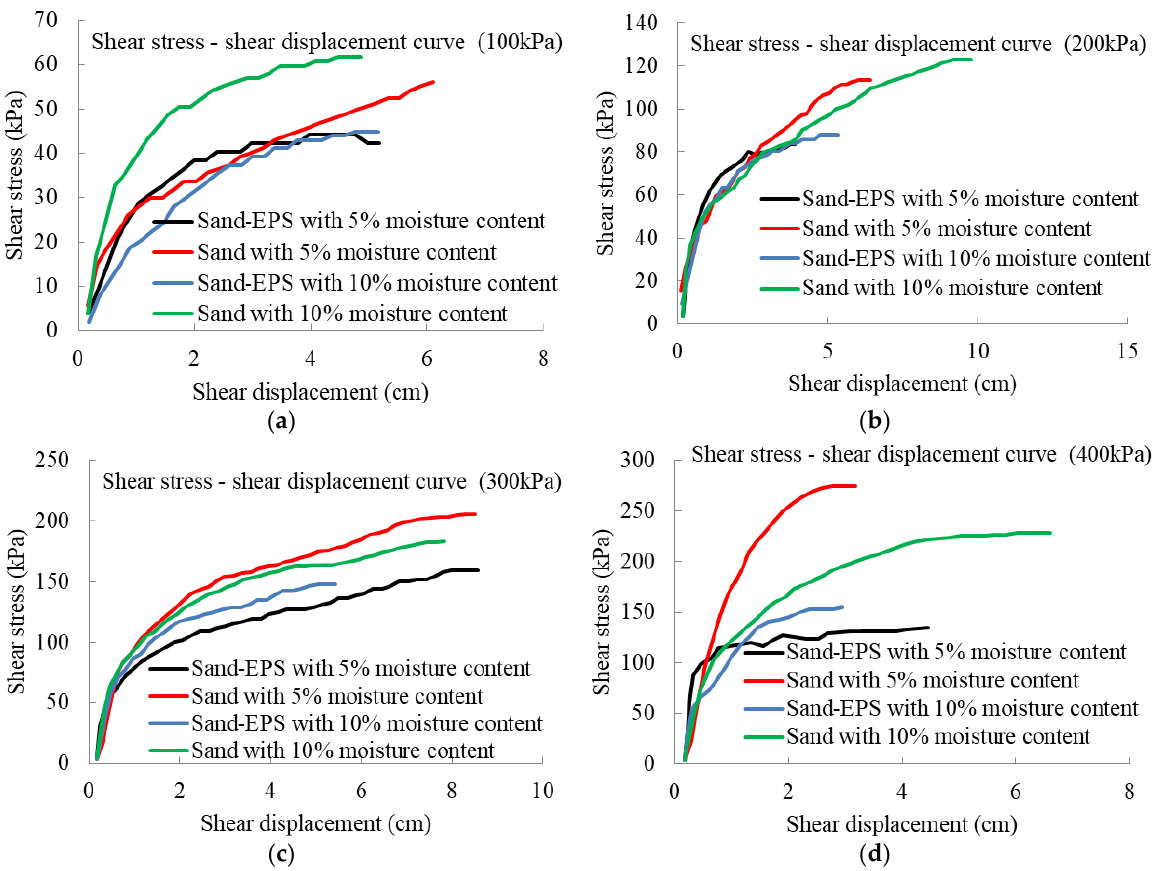
Figure 6. Shear-stress – shear displacement curve for sand and sand – EPS with different moisture contents. ( a ) Curves under the normal stress of 100 kPa; ( b ) curves under the normal stress of